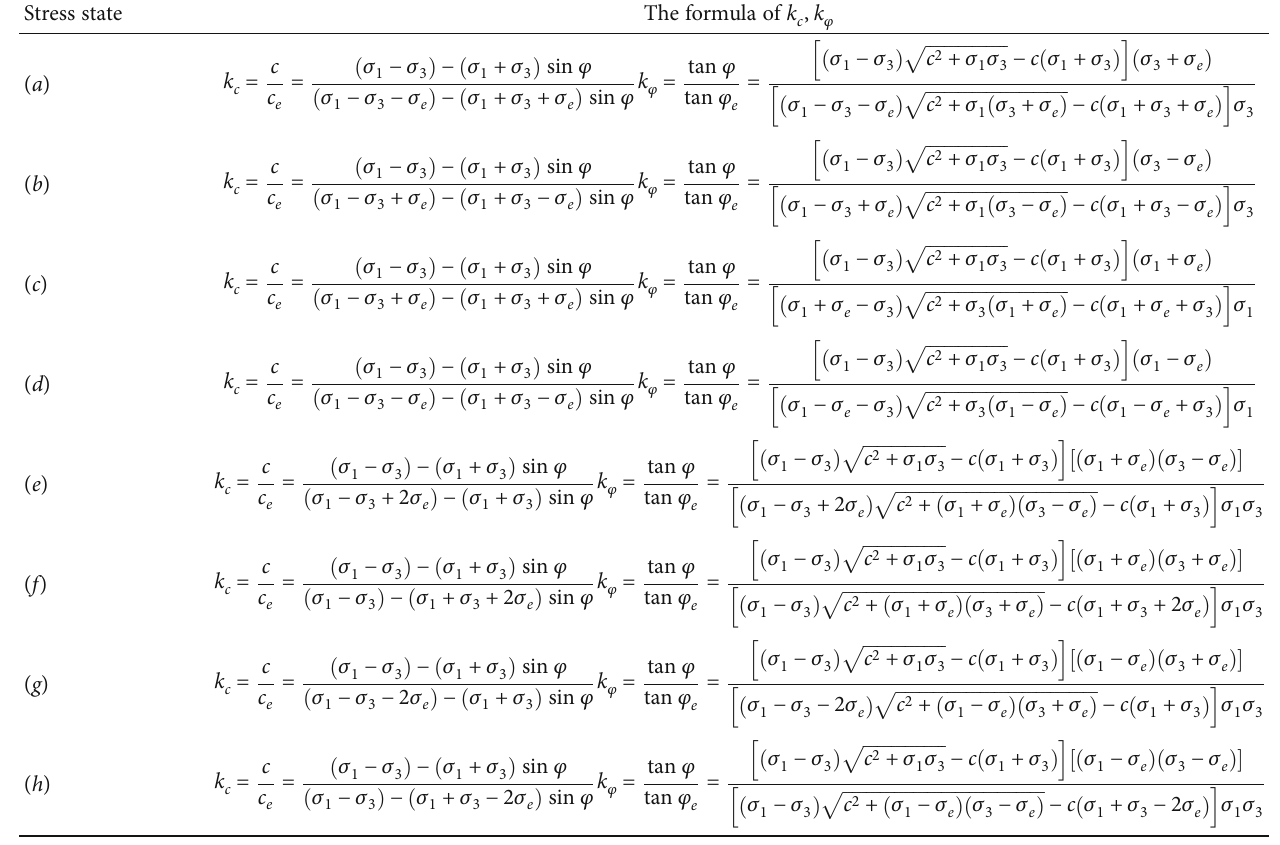
, k c φ for rock joints under engineering disturbance.